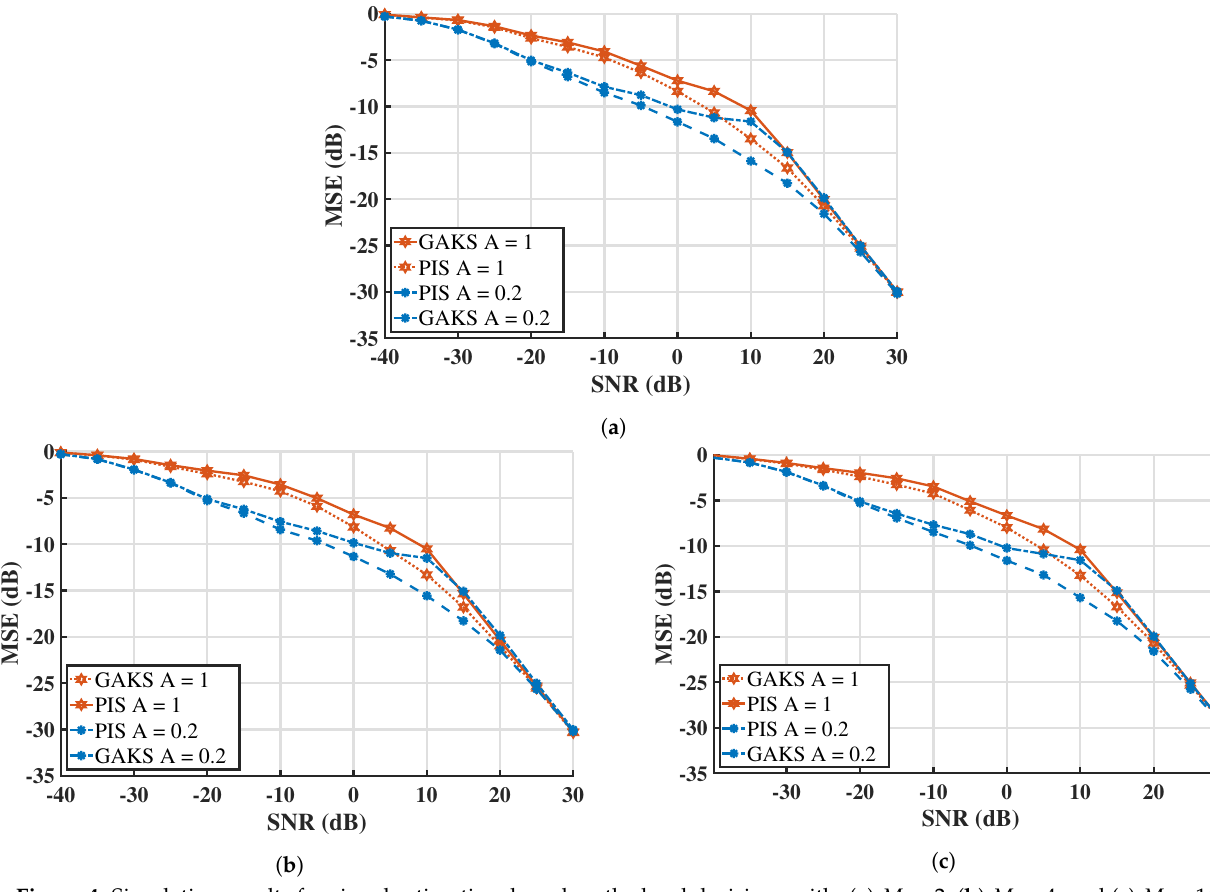
Figure 4. Simulation results for signal estimation, based on the hard decisions with: ( a ) M = 2, ( b ) M = 4, and ( c ) M = 16 impulsive noise states. The signal parameters are a 1 = 0.9 and σ 2 s = 1; the noise parameters are x = 0.9, Γ = 0.01, and A = 0.2 or 1. We transmitted 100 frames of 1000 samples each. GAKS stands for genie aided Kalman smoother and PIS for the parallel iterative schedule of Section